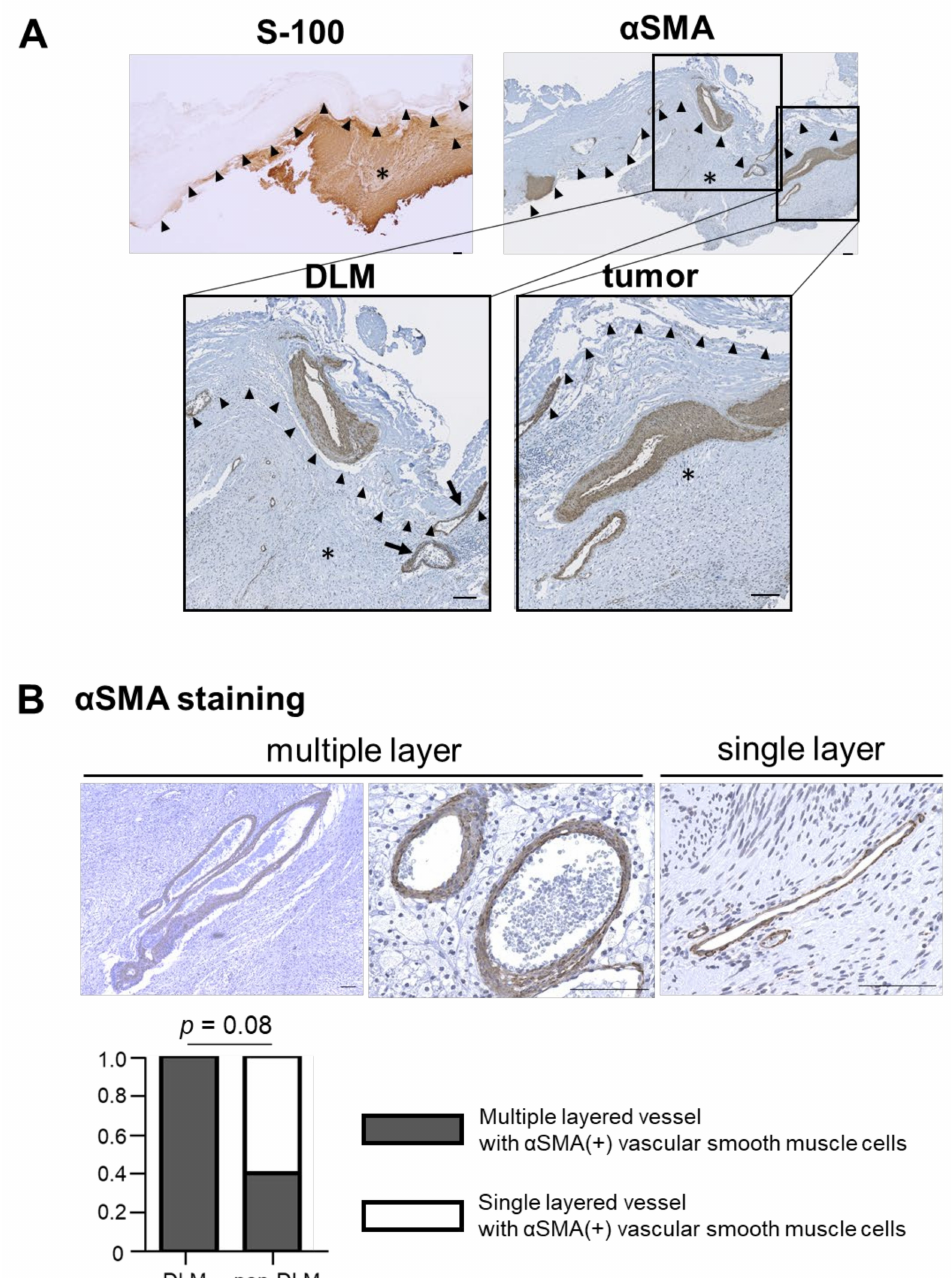
Figure 4. Immunohistopathological analysis of α -smooth muscle actin ( α SMA) staining. ( A ) Tumor, DLM and the borderline are identified using S-100 staining. The α SMA expressions of the tumor and DLM are shown. Multilayered α SMA(+) vessels are identified in DLM, tumor, and the borderline. Low- and high-magnification images are shown (scale bar = 100 µ m). Black arrow, α SMA(+) vessels located on the borderline between DLM and tumor. Black arrow head, borderline between DLM and tumor. *, tumor. ( B ) Multilayered α SMA(+) vessels tend to be more in the tumor of the DLM group than that of non-DLM group ( p =